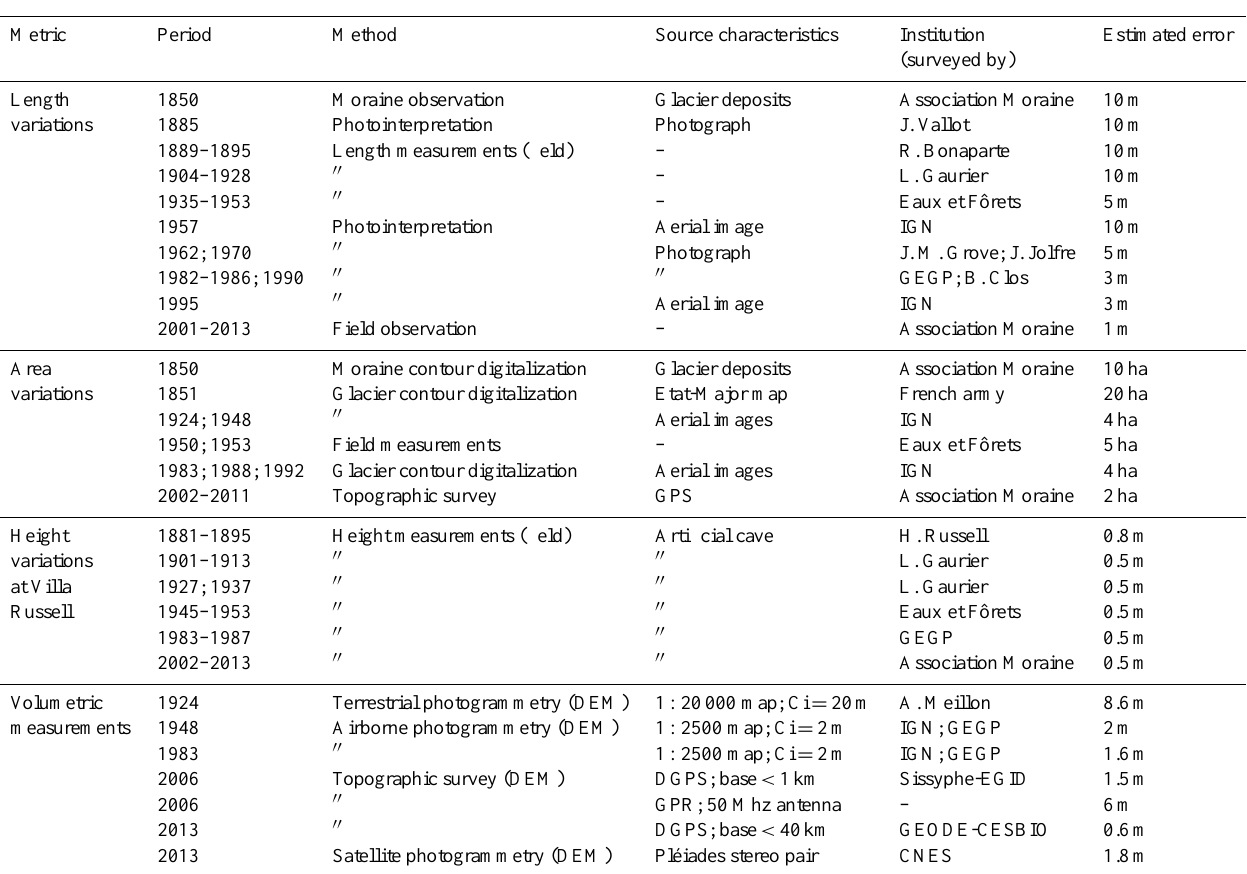
Table 1. Meta-data of Ossoue Glacier topographic survey. Ci indicates the contour interval (m) of the topographic maps. The last column refers to random errors calculated for each type of metric measurements. For volumetric measurements, we give the random error at the elevation associated with the